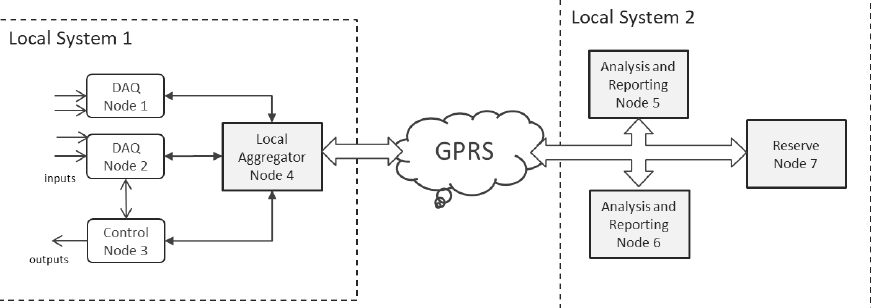
Figure 1. Example of geographically distributed DOORS